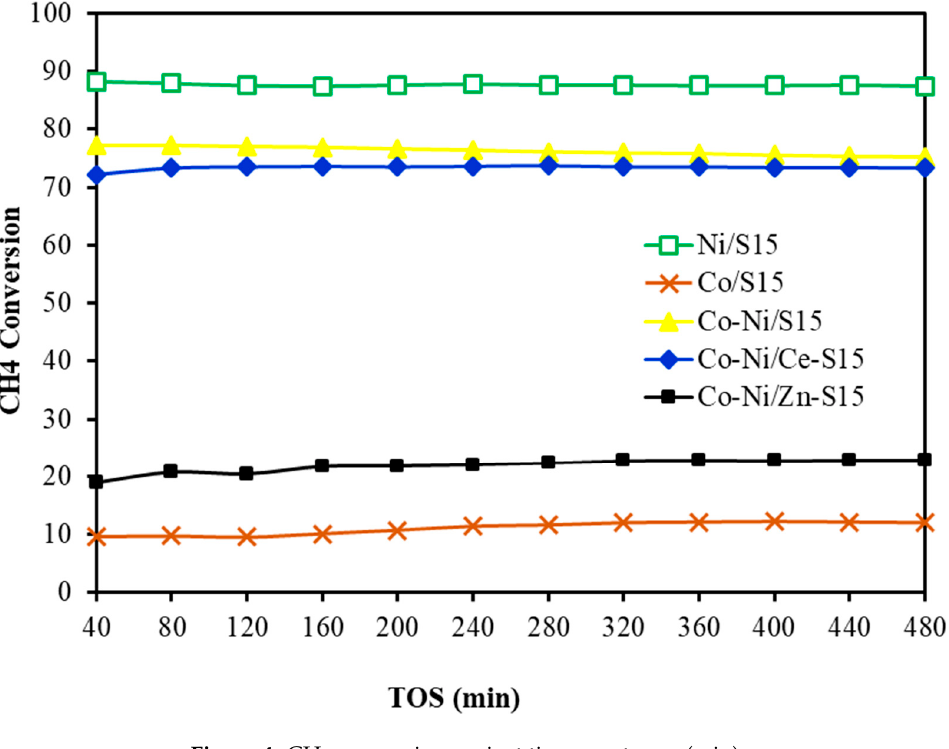
Figure 4. CH 4 conversion against time-on-stream (min).